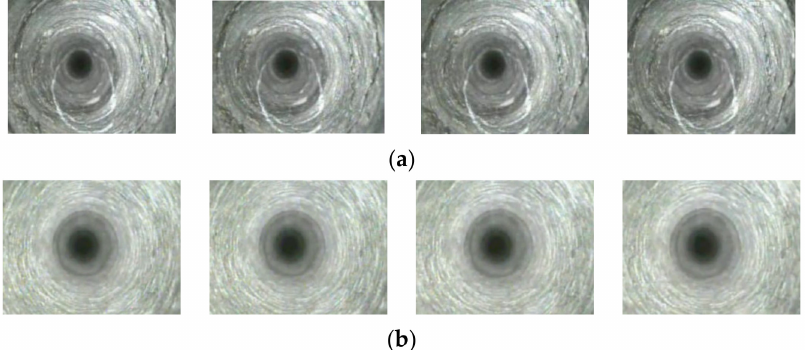
Figure 13. Front view borehole-wall images. ( a ) Sample sequence of video 1; ( b ) sample sequence of video